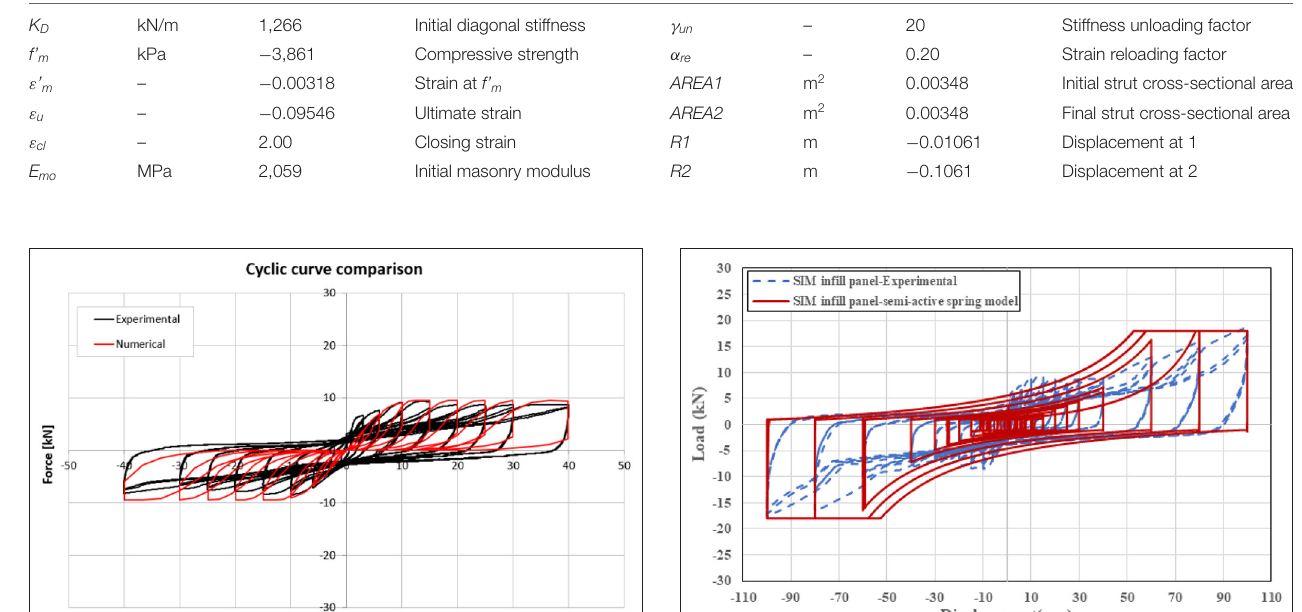
TABLE 3 | Parameters of the diagonal struts for semi-interlocking masonry (SIM) of the University of Newcastle.